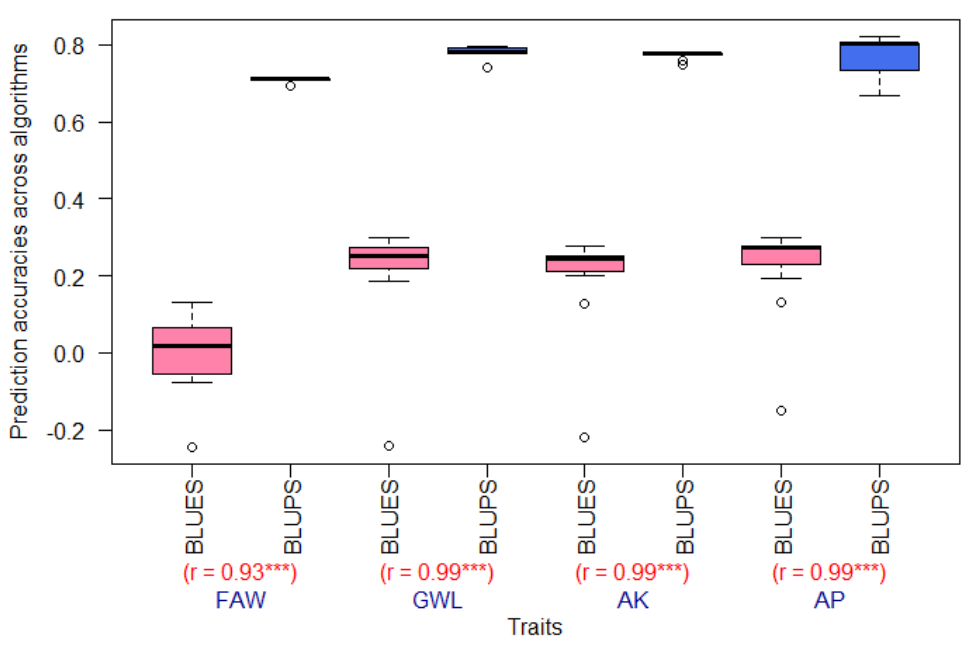
Figure 1. Boxplot of PAs (prediction accuracies) for best linear unbiased estimators (BLUEs) (in pink) and predictors (BLUPs) (in blue) of maize resistance to FAW and MW across prediction models and correlations (r) between BLUEs and BLUPs for each trait. FAW, fall armyworm; GWL, grain weight loss; AP, adult progeny emergence; AK, number of affected kernels. *** significant at p < 0.001